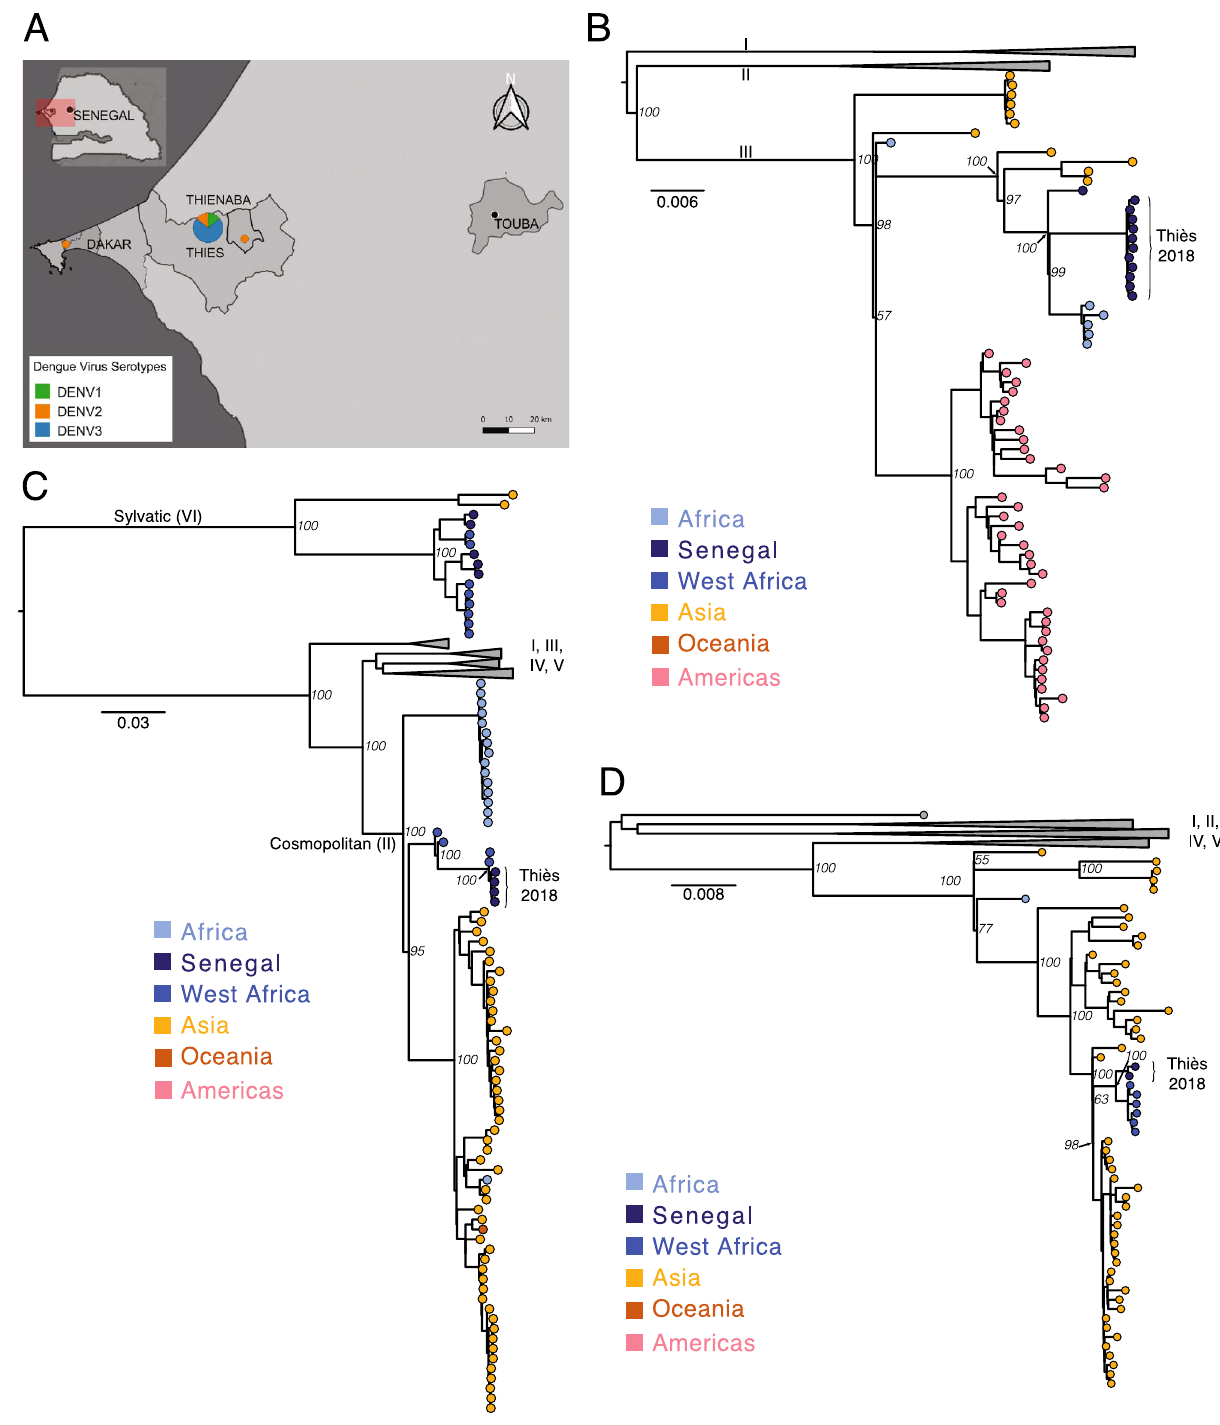
Figure 2. Phylogenetic analysis of dengue virus genomes from Senegal. ( A ) Map showing the locations of DENV cases identified in this study by virus serotype the size of the dot is proportional to the number of samples. Major cities, including Thiès—the sampling site—and Touba—the location of the Magal—are also shown. This map was created using QGIS v3.4.7 (http:// www. qgis. osgeo. org). ( B ) DENV3 maximum likelihood (ML) phylogeny: genomes from Thiès are in genotype III and are most similar to genomes from Africa. ( C ) DENV2 ML phylogeny: genomes from Thiès are in the Cosmopolitan genotype and are most similar to other West African genomes. ( D ) DENV1 ML phylogeny: genomes from Thiès are in genotype III and are most similar to genomes from West Africa. Bootstrap values for key nodes are